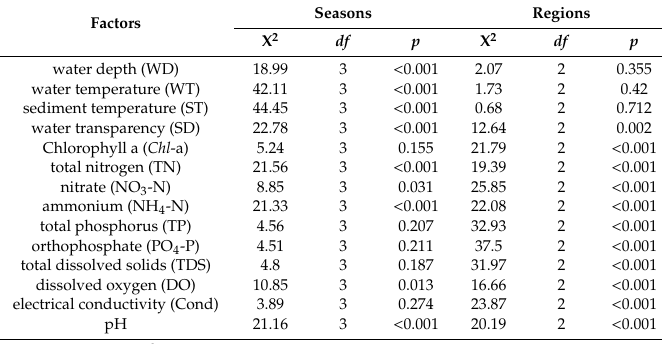
X 2 : Chi square value; df: degree of freedom.